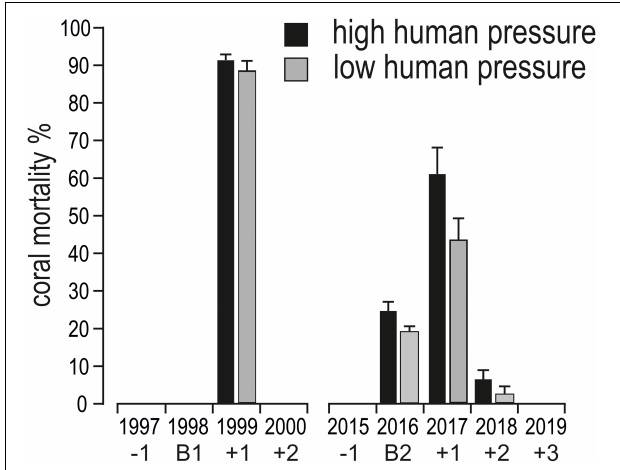
FIGURE 6 | Mean ( + standard error) coral mortality (in %) in shallow reefs (5 m depth) of the Maldives in the years before (–1, i.e., 1997, 2015), during (B1, i.e., 1998, and B2, i.e., 2016), in the 2 years after (+1 and +2, i.e., 1999 and 2000) the mass bleaching event of 1998, and in the 3 years after (+1, +2,